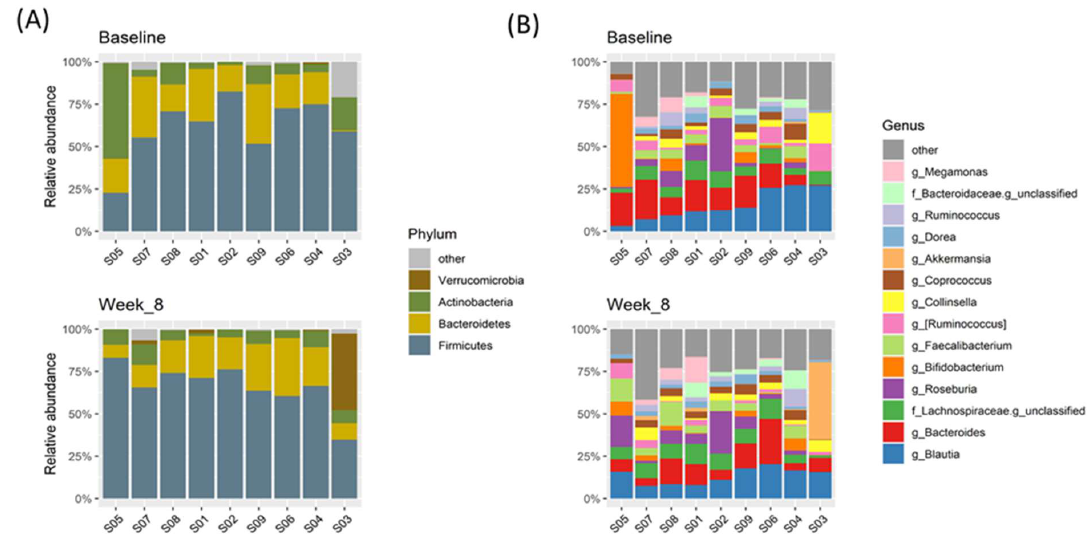
Figure 1. Microbiota composition at phylum and genus levels of each fecal sample at the two collection times. ( A ) Firmicutes was the most dominant phylum within almost all fecal samples. The differences of microbial abundance did not change significantly between the two sample collection times. ( B ) Almost all fecal samples were dominated by Blautia and Bacteroides , except one sample. Sample ID S05 was dominated by Bifidobacterium , of which relative abundance exceeded 50% at baseline but reduced to less than 15% at eight weeks.